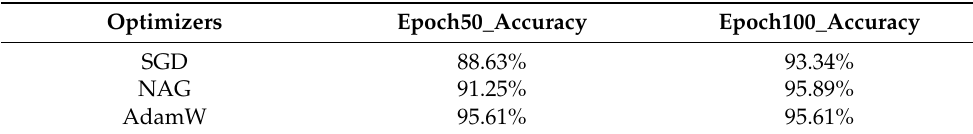
Table 4. Comparison of accuracy of different optimizers.